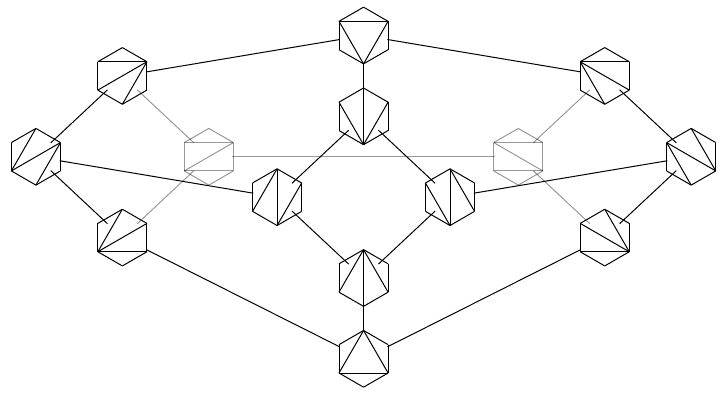
Figure 1 . Graphical depiction of the (cid:12)fth Stashe(cid:11) polytope. Each vertex of this three-dimensional polytope is associated with a triangulation of a 6-gon while every edge represents a 2{2 Pachner move. The combinatorics of this object is exactly the same as the one of the coherence relation of the pentagonator which is one of the structural 2-morphisms entering the de(cid:12)nition of the monoidal 2-category we are interested